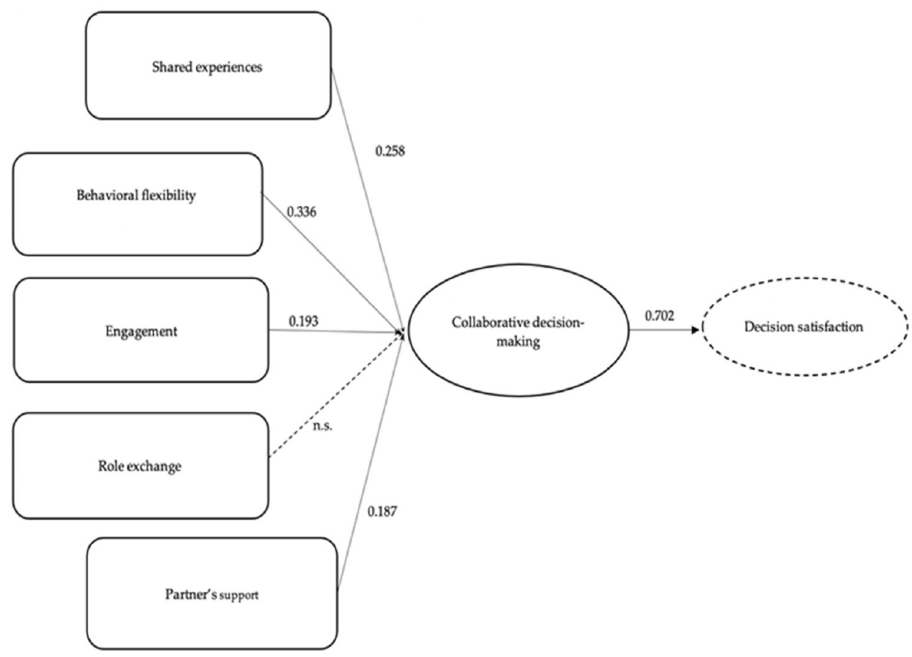
Figure 2. The conceptual model with empirical results included (St.beta).